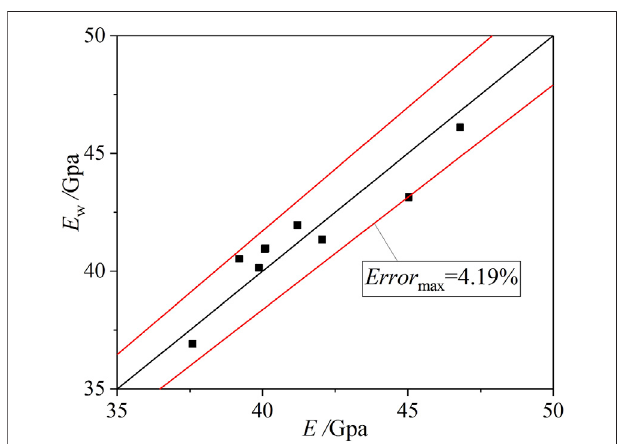
FIGURE 13 | The comparison between E and E w for 9